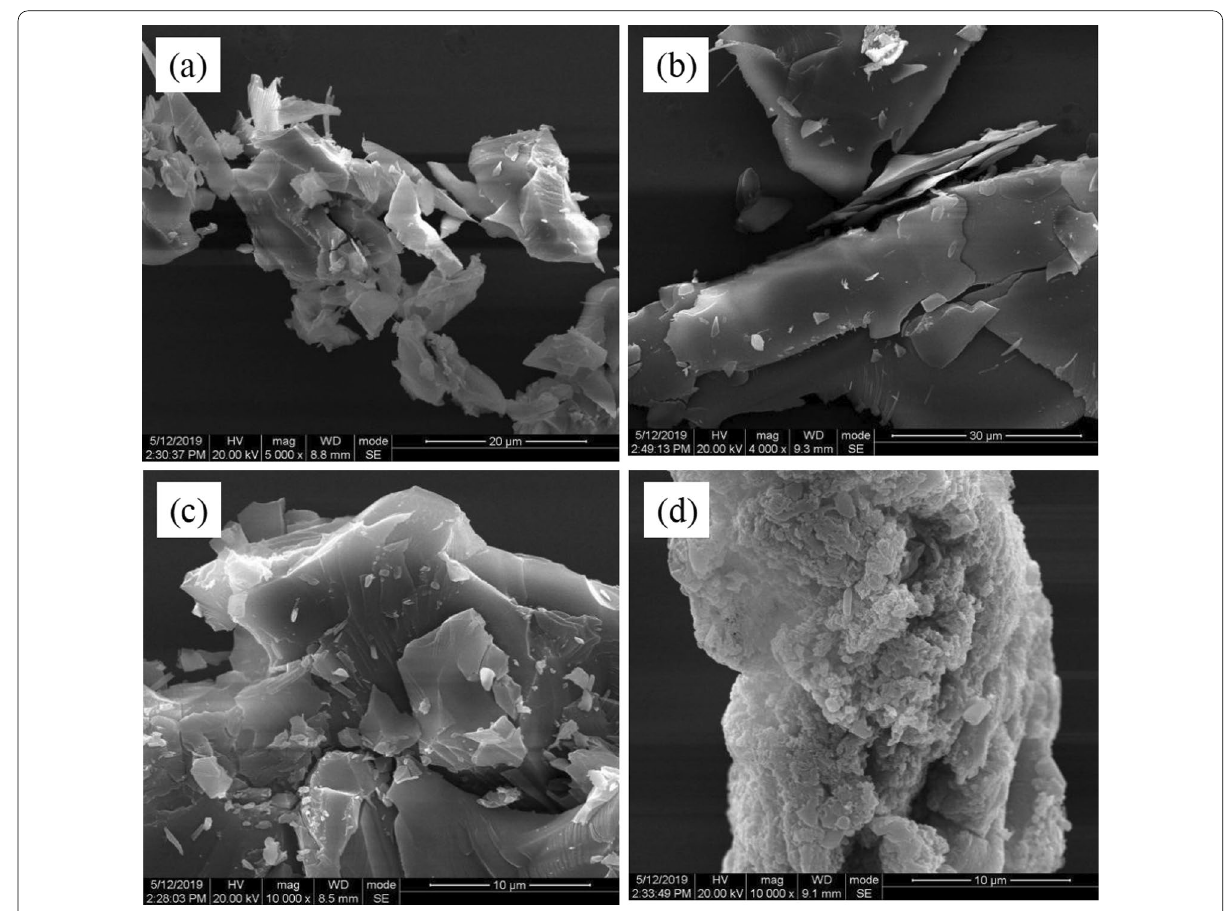
Fig. 5 SEM images of MoS 2 nanosheets under different ultrasonic power. The ultrasonic powers are a 240 w, b 360 w, c 480 w, d 600 w, respectively